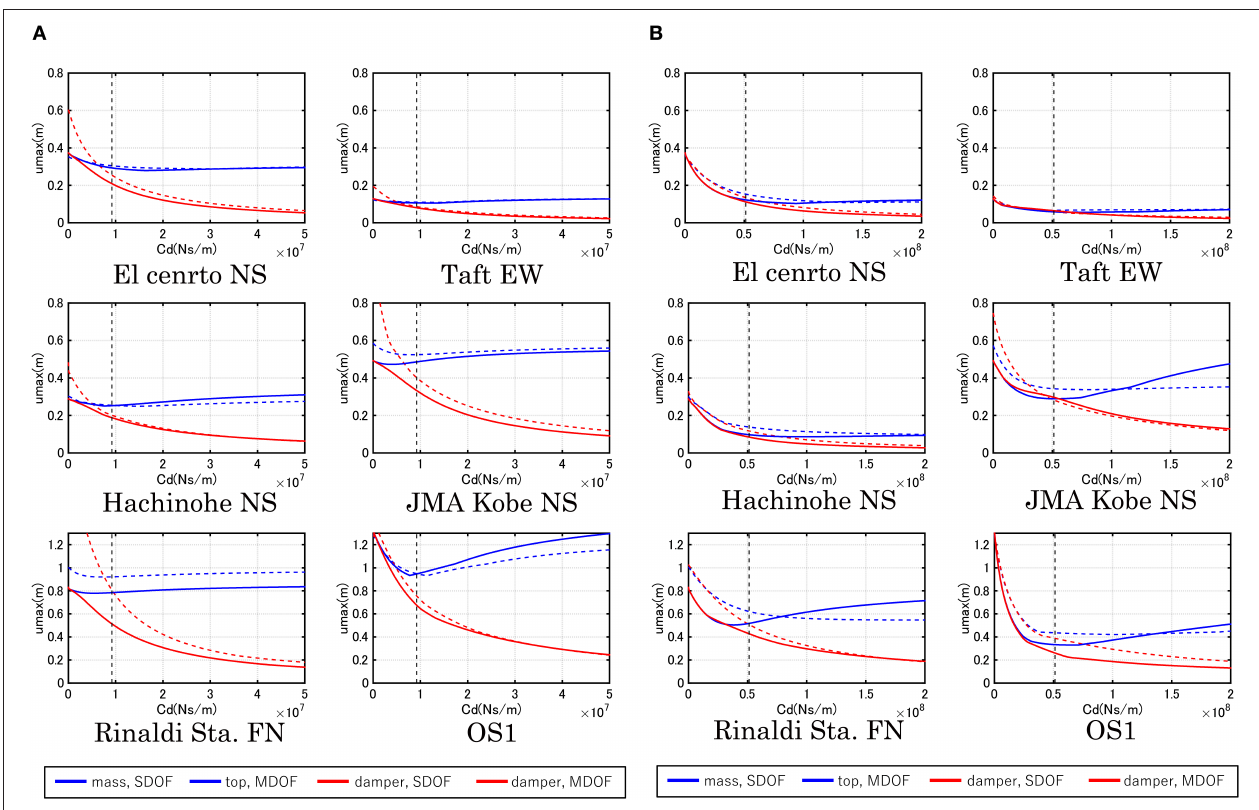
FIGURE 10 | Simplified evaluation of maximum top displacement and maximum damper deformation. (A) Original Model and (B) Stiffer Model.